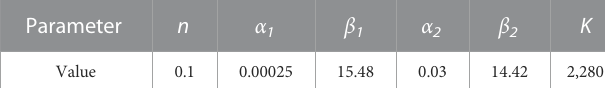
TABLE 1 Parameters for FLO-2D.